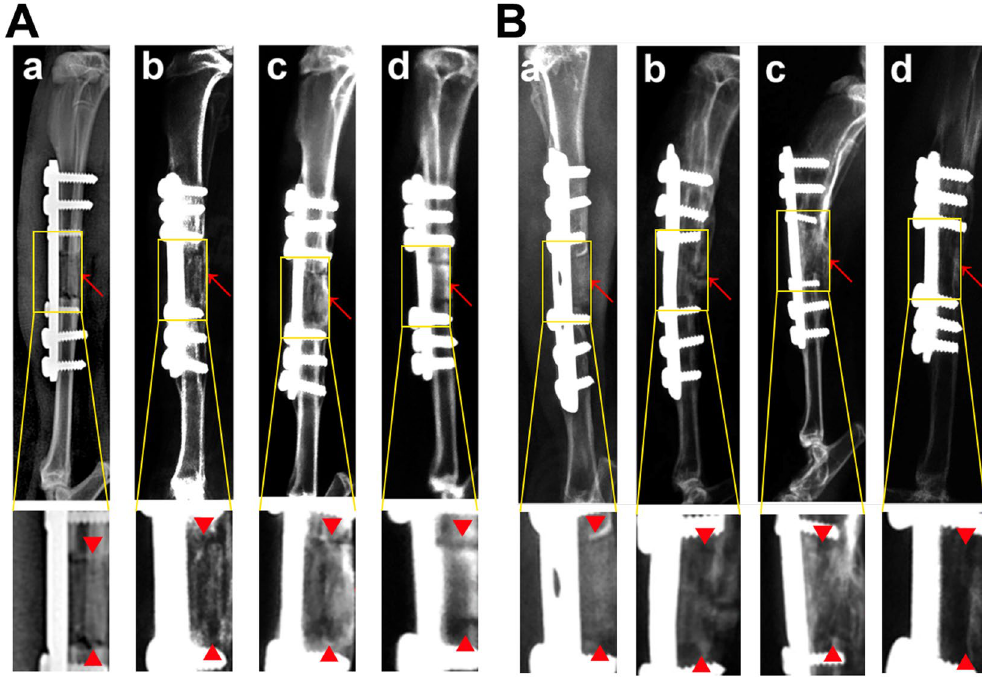
Figure 9. X-ray scanning of control (a), B (b), VB (c) groups and autogenous bone (d) after implantation for 4 weeks ( A ) and 12 weeks ( B ). The lower images were magnified from the corresponding regions. Red arrows indicate the bone defect edges.